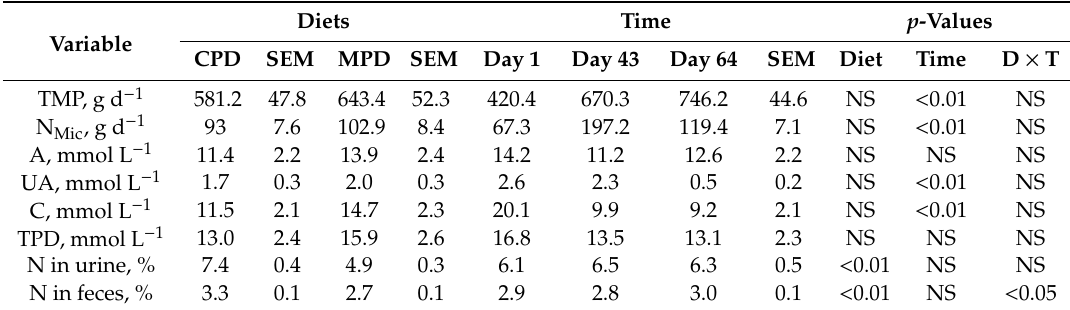
CPD = Crude Protein Diet; MPD = Metabolizable Protein Diet; SEM = Standard error of the mean; TMP = Total microbial protein; N Mic = Microbial nitrogen; A = Allantoin; UA = Uric acid; C = Creatinine; TDP = Total purine derivatives (allantoin + uric acid); N urine = Concentration of nitrogen in urine; N feces = Nitrogen concentration in feces; NS = Not